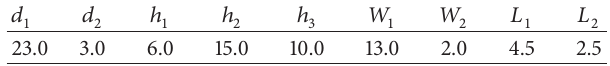
Table 1: Parameters for the optimized DRA (unit: